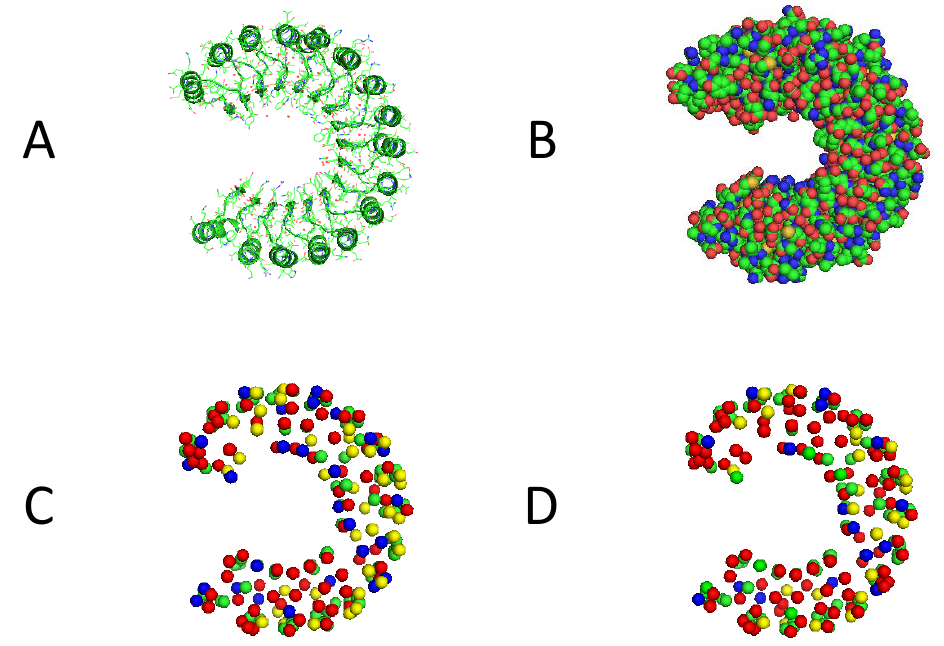
Figure 3. Visualization results of predictions by the proposed methods. ( A ), ( B ) represent the cartoon and spheres form of 1a4y-a, and ( C ), ( D ) represent predictions based on RENN-XGB and IHT-XGB methods, where green, red, yellow, and blue ball represent the predictions of TP, TN, FP and FN, respectively.